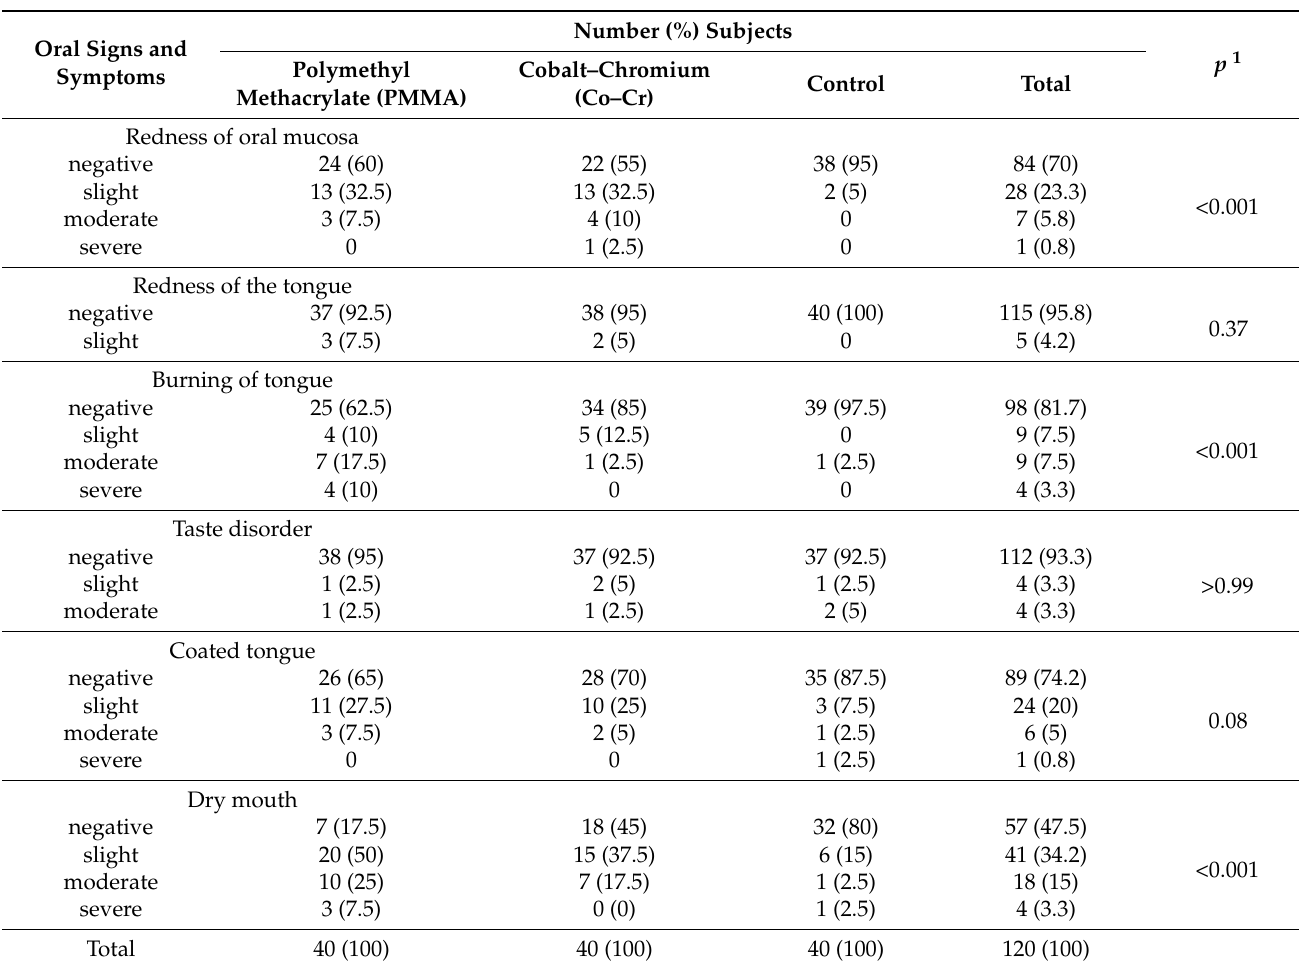
Table 4. Oral signs and